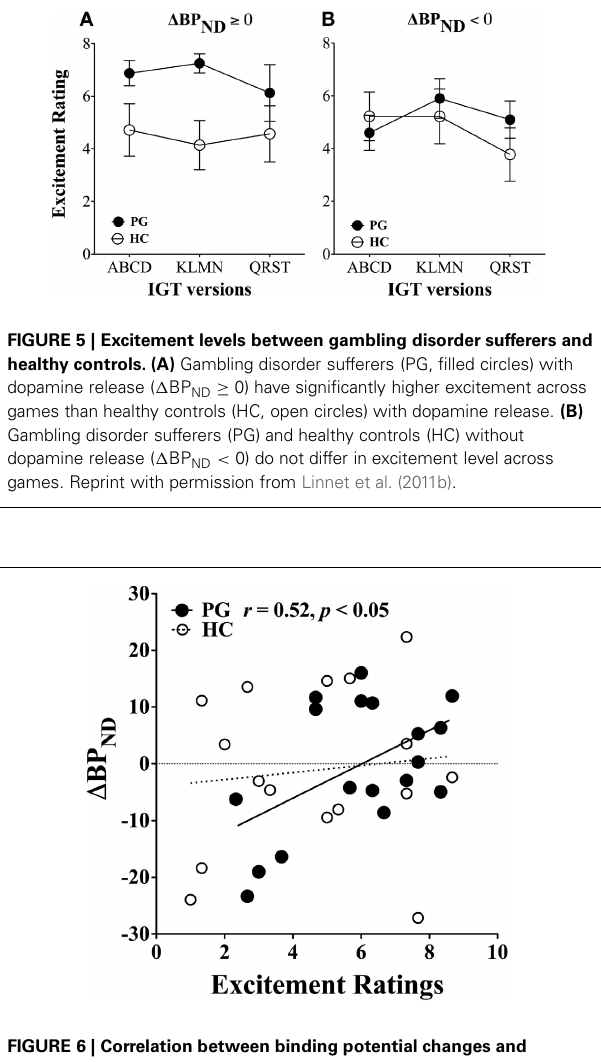
FIGURE 6 | Correlation between binding potential changes and excitement level. Gambling disorder sufferers (PG, filled circles) show a significant correlation between excitement level on the abscissa and change in binding potential ( (cid:2) BP ND ) on the ordinate, while the correlation fail to reach significance level in Healthy Controls (HC, open circles). Values above zero indicate dopamine release, while values below zero indicate dopamine inhibition. Reprint with permission from Linnet et al.